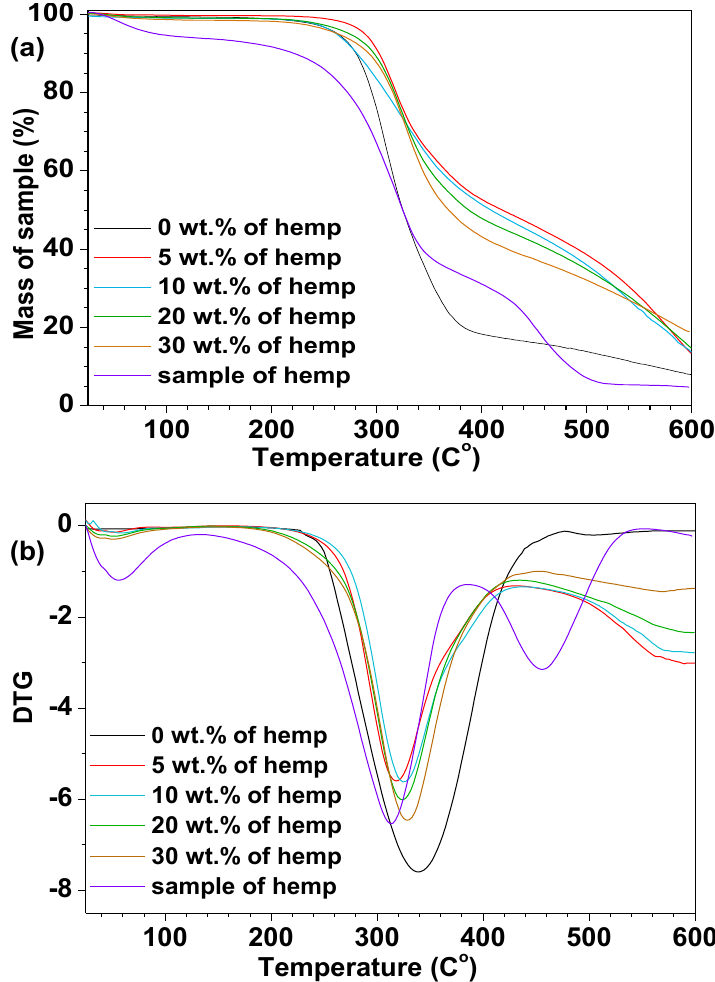
Figure 5. Thermal analysis: ( a ) TGA and ( b ) DTG curves of composites. Table 3. TGA and DTG data of the samples.